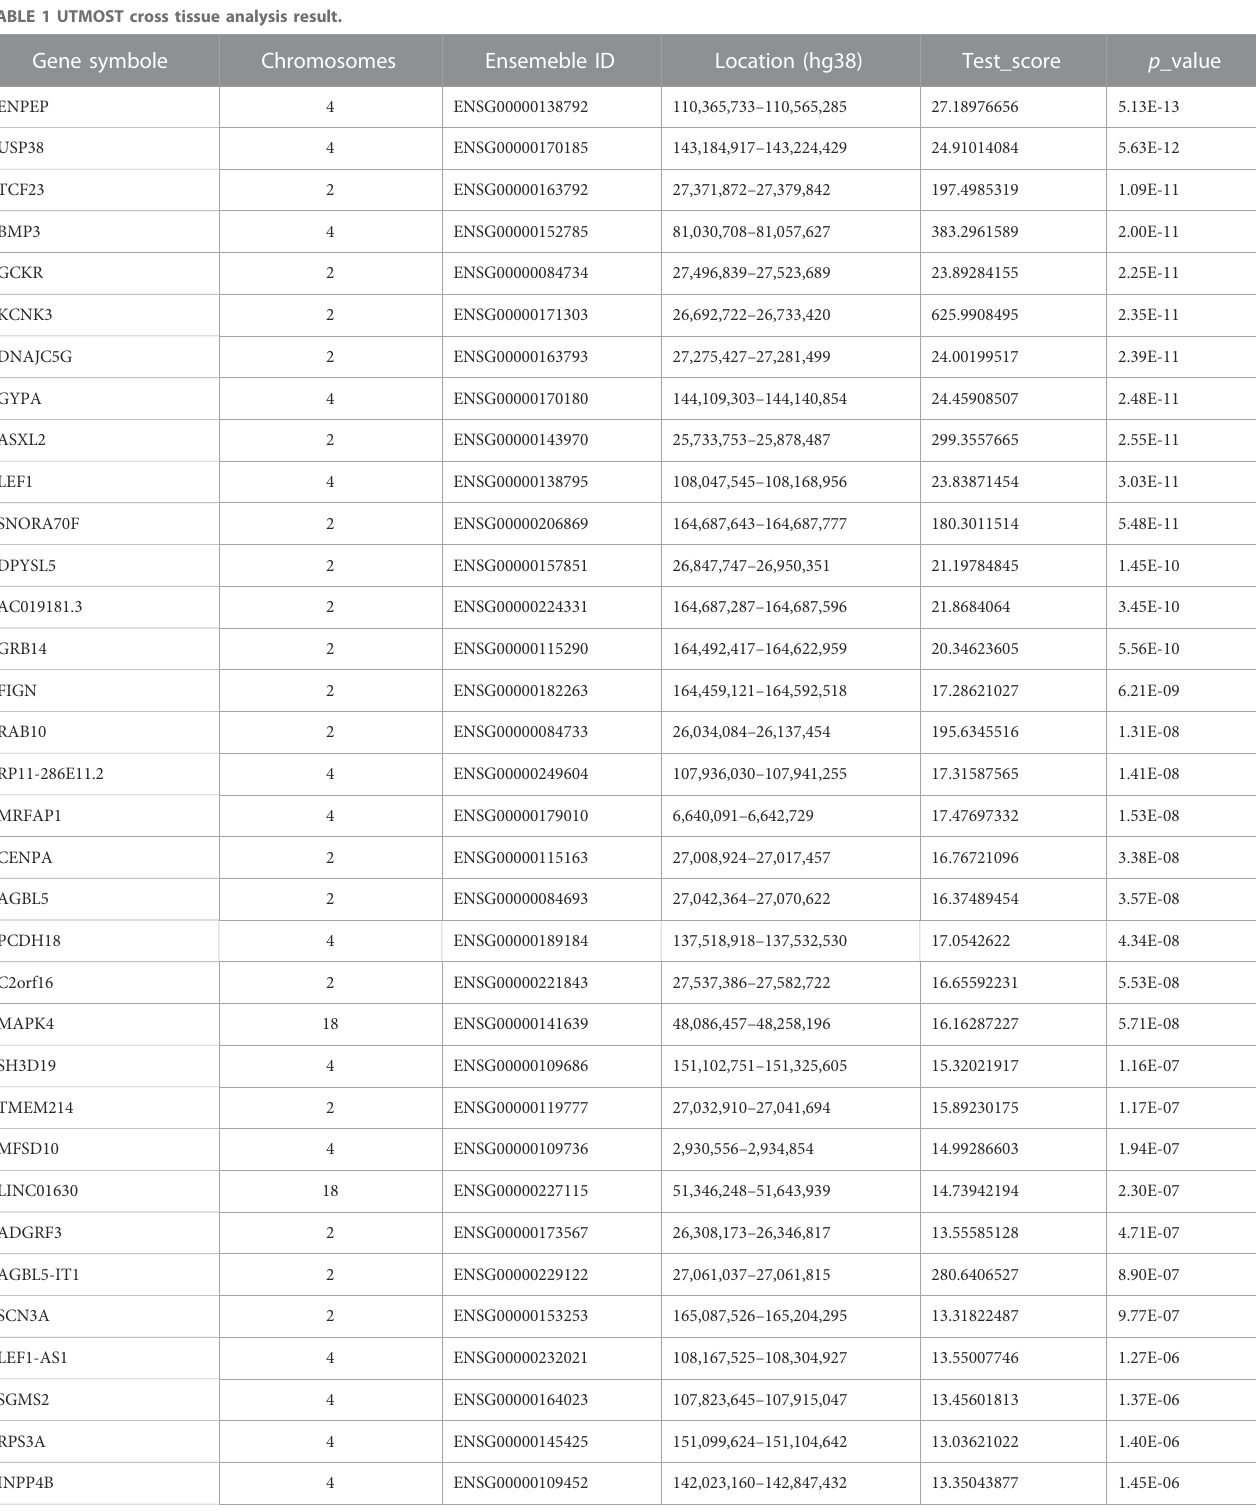
TABLE 1 UTMOST cross tissue analysis